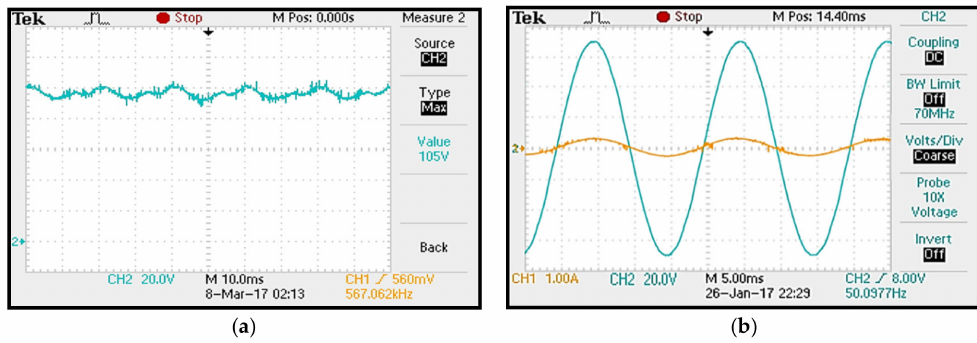
Figure 14. Grid side converter experimental waveforms: ( a ) experimental DC-link voltage (V), and ( b ) experimental phase voltage and